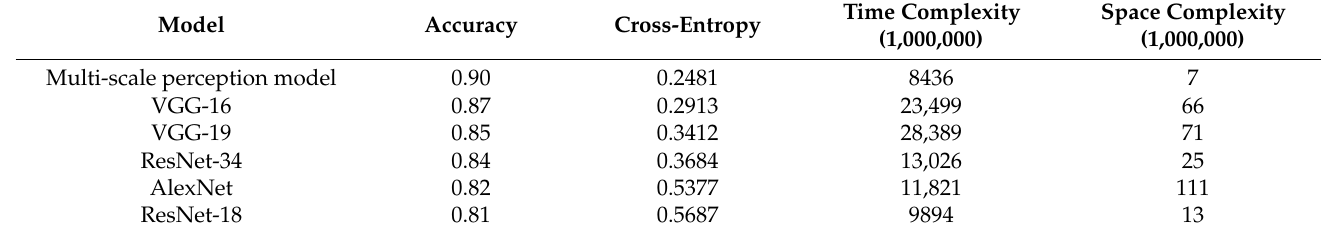
Table 3. Performance comparison of different algorithms.